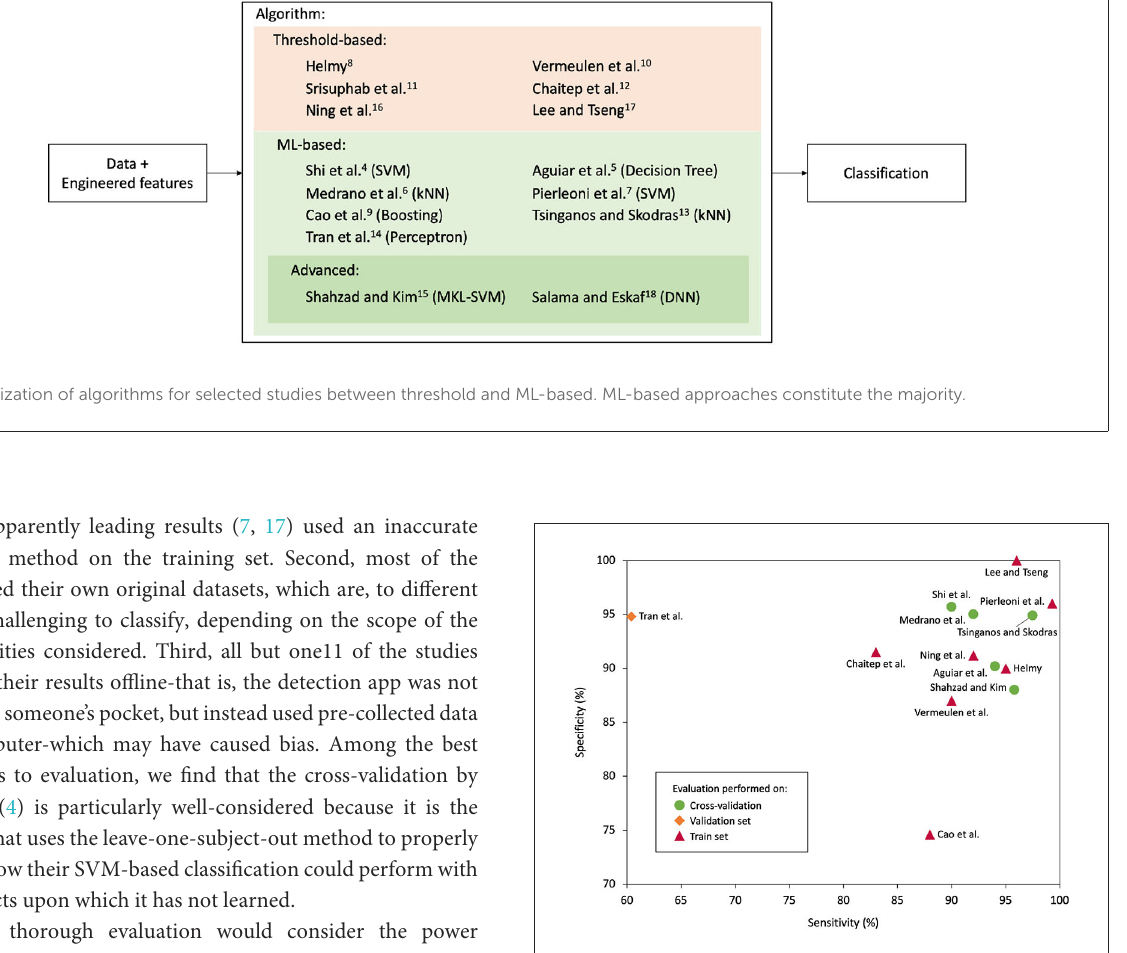
FIGURE8 Sensitivity and specificity, if available, for the selected studies. The two best results do not use cross-validation as their evaluation method which may hint at an overestimation of their